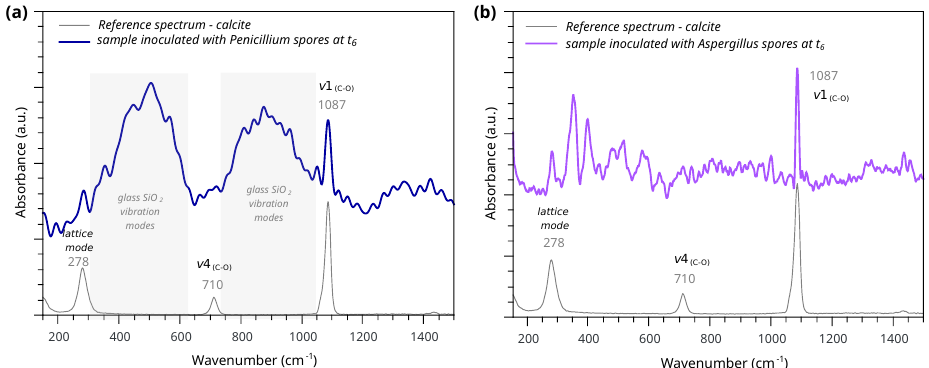
Figure 5. Raman spectra of the idetified crystalline products on the glass surfaces inoculated with ( a ) weddelite (CaC 2 O 4 · H 2 O) identified in PS1 in PDA at t 6 identified according to literature data [22,23], and ( b ) calcium carbonate (CaCO 3 ) identified in AS1 in PDA at t 6 , identified according to literature data